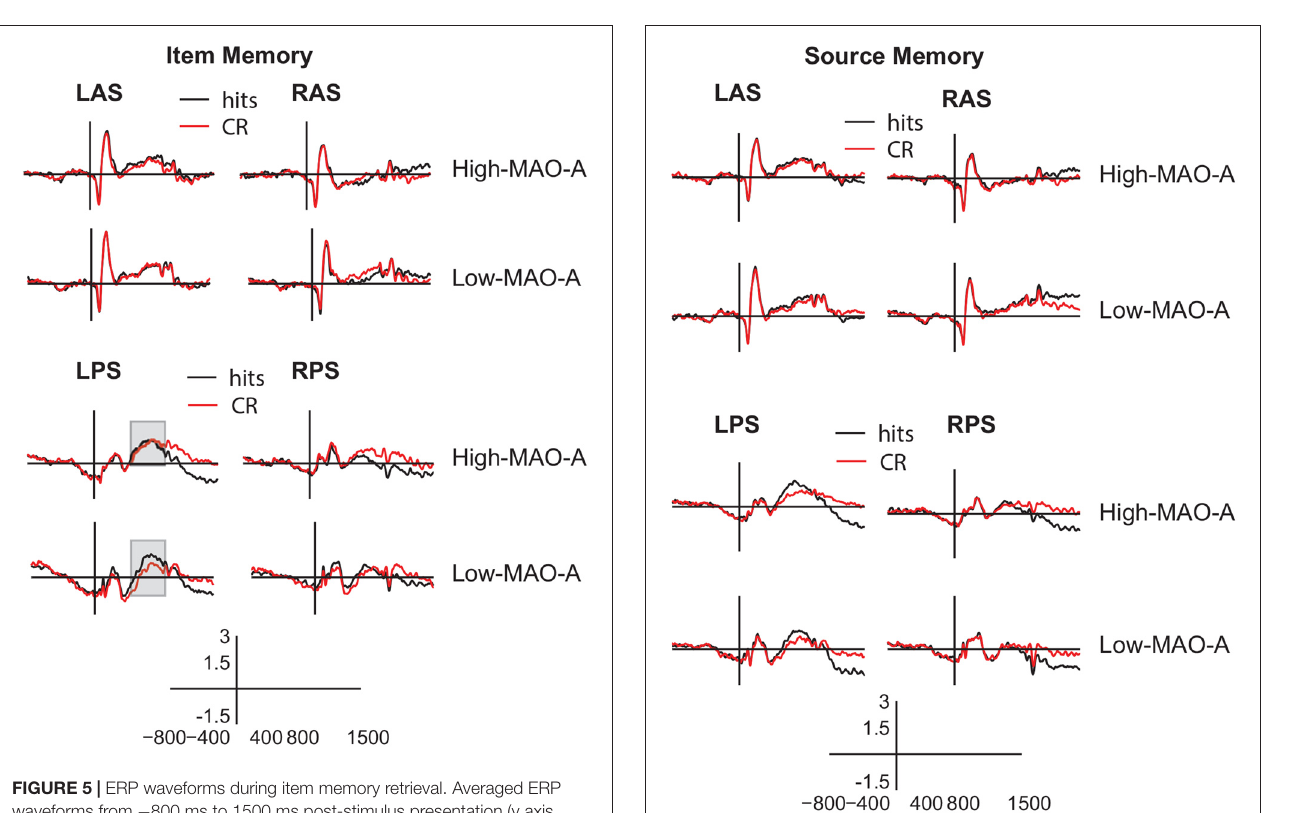
MAO-A ( t ( 36 ) = 2.649, p = 0.012, Cohen’s d = 0.44)